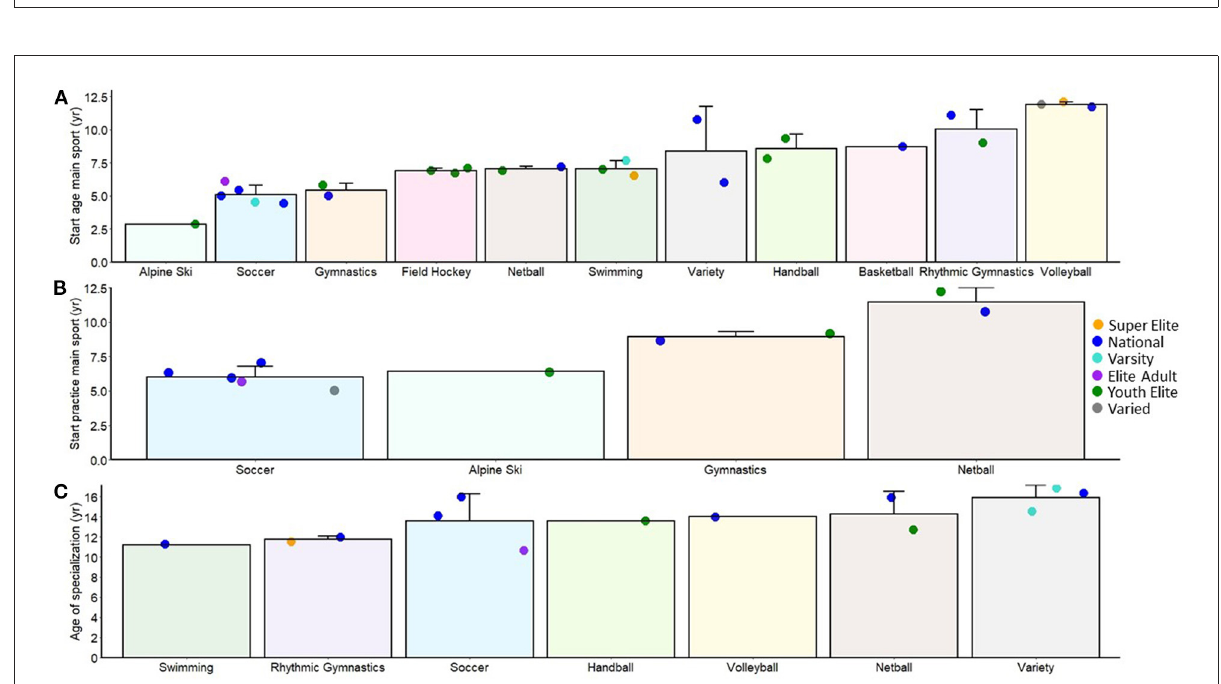
FIGURE3 Sample (bar) and individual study means (colored circles) across different sports showing start age in the main sport (A) , start age in practice (B) and start age of specialization (C) . The sports are ordered in terms of start age and expertise category is shown in terms of a color coded grouping variable. Error bars show sample standard